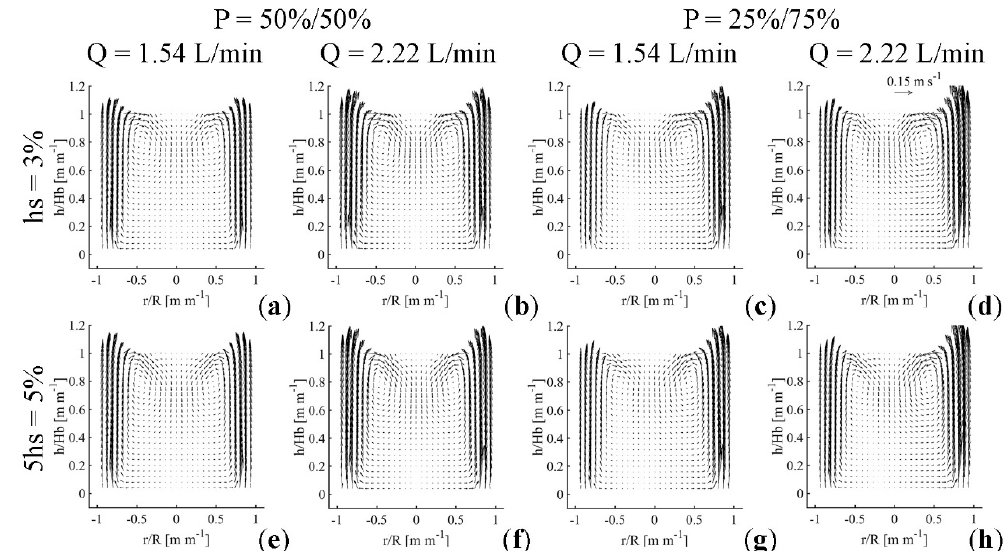
Figure 3. Flow patterns of the eight case studies obtained with the numerical model and shown along the same longitudinal plane. ( a ) through ( h ) are the experiments described in Table 2. The cases presented in this study are in the same order as in the experimental study of Jardón-Pérez et al. [15] .